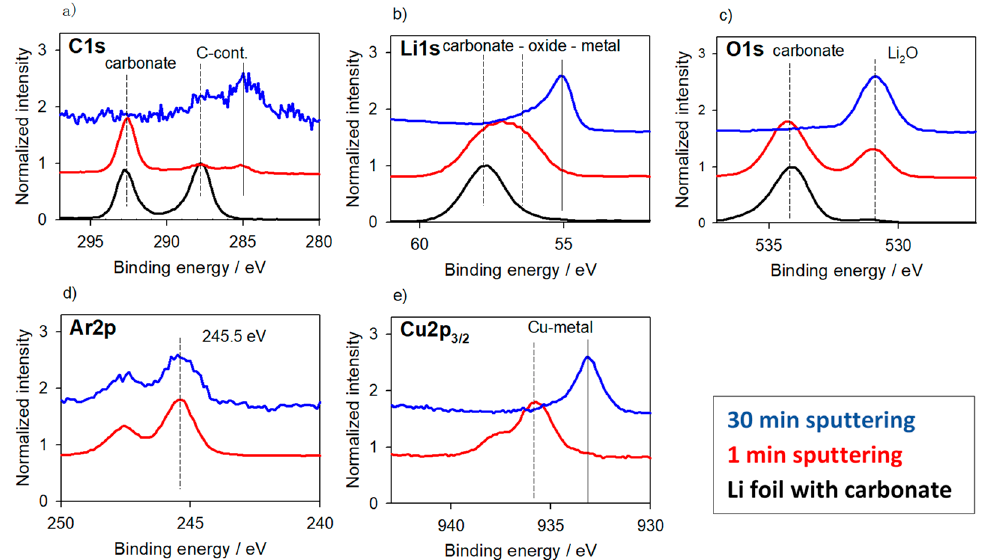
Figure 1. XP spectra normalized in intensity of a native Li foil from the glove box and after short and long-time sputtering ( bottom to top ). No charging is observed. Cu metal is deposited as additional reference material. The foil is covered with Li-carbonate. All characteristic spectra are shifted to high binding energy (BE). Only after long time sputtering Li is found in metal position (Li1s 55 eV) and Cu (Cu2p 3/2 933 eV); Ar2p remains in high BE position (245.5 eV). As in all following figures, too, the solid vertical lines mark peak positions in agreement with the conventional C-H-referencing; dashed vertical lines mark the positions shifted by the “alkaline effect” to higher BEs. ( a ) C1s; ( b ) Li1s; ( c ) O1s; ( d ) Ar2p; ( e ) Cu2p 3/2 transition.